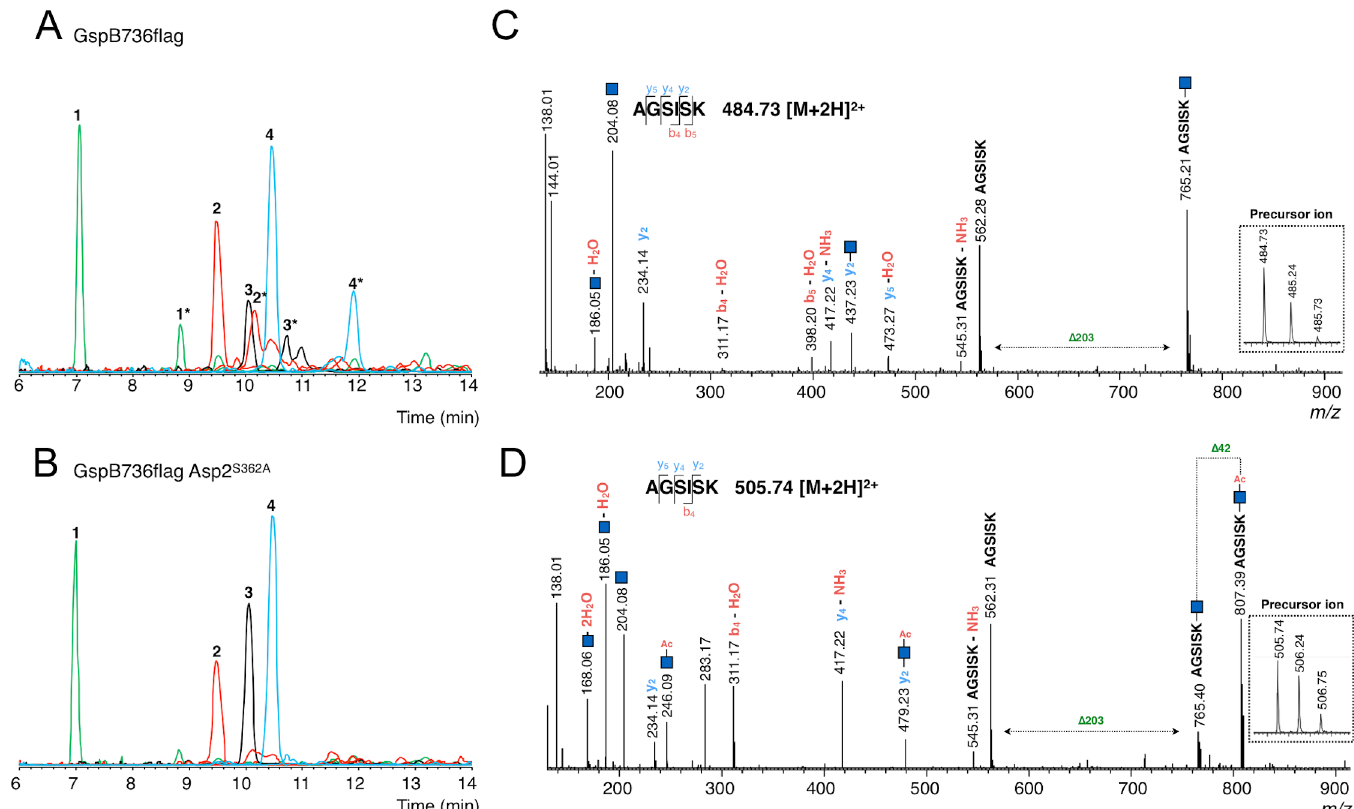
Fig 3. Q-TOF LC/MS analysis of GspB736flag after trypsin, Lys-C, and Glu-C protease digestion. Extracted ion chromatograms for all detected glycopeptides derived from GspB736flag secreted from A) a Δ gly-nss strain (PS3309)or B) a Δ gly-nss Asp2 S362A strain (PS3540). Peaks with the same peptidebackboneare designated with the same color (green, red, black and blue, respectively)and asterisks denote those containingan O-acetylated glycopeptide. C) Fragmentation spectrum of peak 1, m/z = 484.73[M+2H] 2+ O-glycosylated at two positions.D) Fragmentation spectrum of peak 1 * , m/z = 505.74[M+2H] 2+ O-glycosylated at two positionsand O-acetylated at one position. O -GlcNAc modifications are designatedby a blue square. MS spectra of precursor ions are shown in the insets.